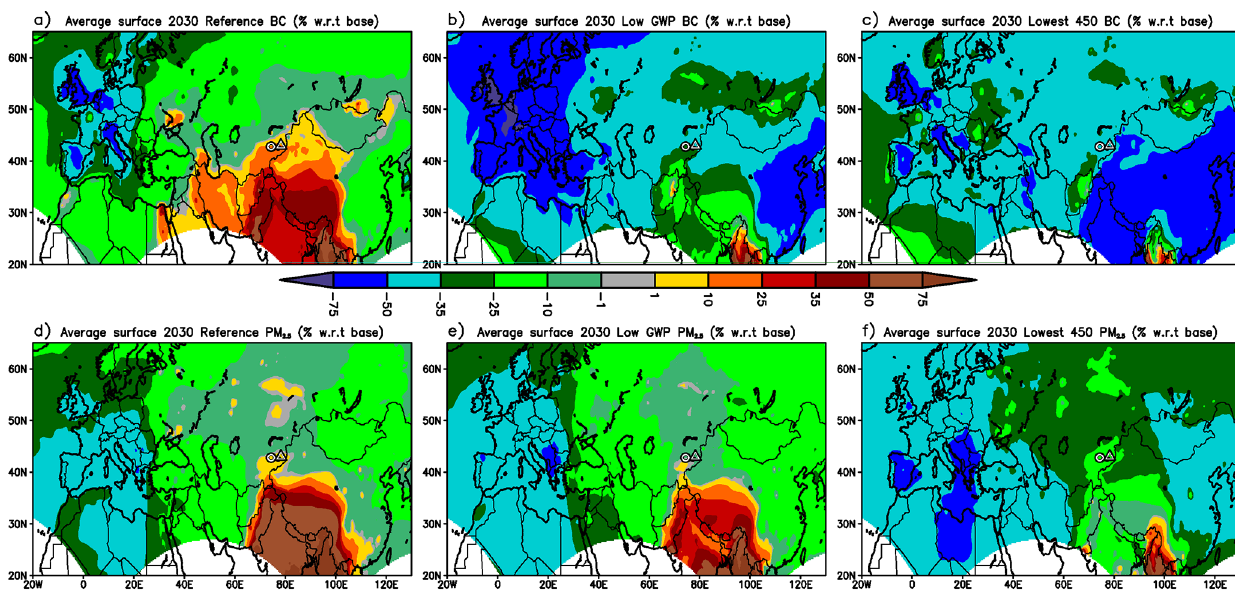
Figure 19. Percent change in simulated period mean surface BC and PM 2 . 5 concentrations for future 2030 emission scenarios relative to the base year (2005), (a, d) reference 2030, (a, e) BC measures (low), and (c, f) BC (lowest) and greenhouse gas measures aimed at keeping CO 2 levels below 450ppm. Refer to Sect. 2.3 for more details on emission